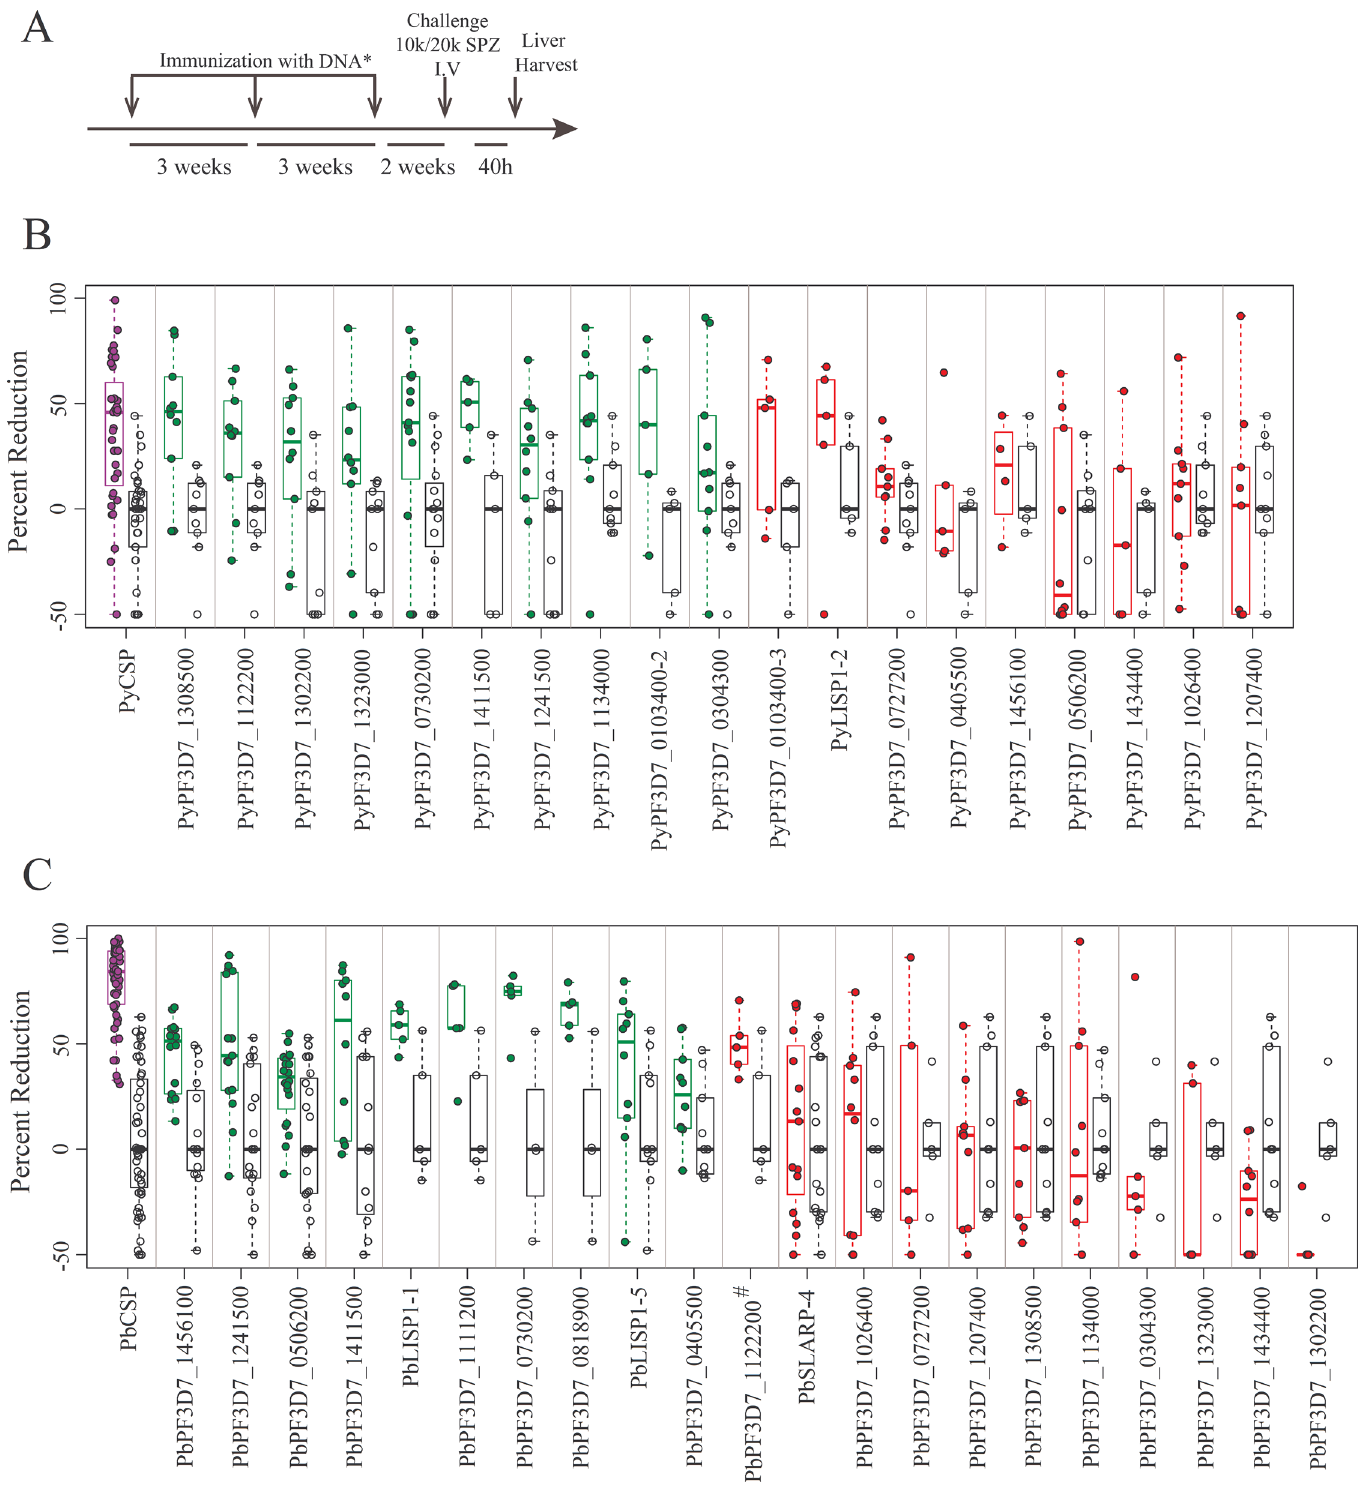
Fig 2. GG DNA immunization and reduction of LS parasite burden post-sporozoite challenge. (A) Experimental design for the immunization and challenge studies. Mice were immunized 3 times at 3 week intervals with VR1020 plasmid DNA carrying the Pb or Py antigen. Two weeks after the last boost mice were challenged with 10,000 Pb or 20,000 Py sporozoites intravenously and livers were harvested 40h post-challenge. * DNA dose is 5 μ g (GG), 25 μ g + 35 μ g GM-CSF DNA (IM) or 20 μ g (EP). (B) Meta-analyses of 7 independent immunization experiments and resulting LS parasite burden reduction in Py in